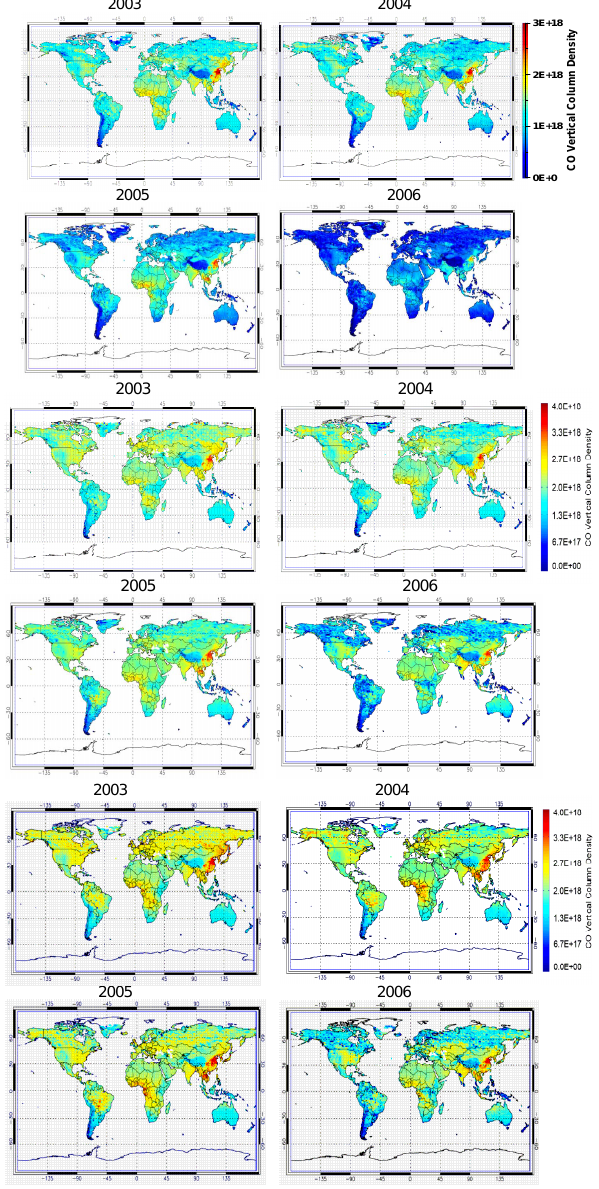
Fig. 3. Global annual mean CO distribution for uncorrected data (top), after normalization with MOPITT (center) and after ad- ditional cloud correction (bottom). Note the different colour scales. The differences between results for the different correction steps are shown in the appendix (Fig.